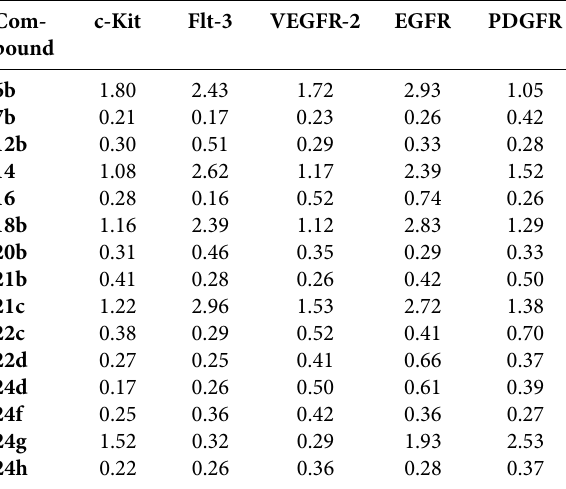
Table 3 . Inhibition of tyrosine kinases [enzyme IC 50 (nM)] by com- pounds 6b , 7b , 12b , 14 , 16 , 18b , 20b , 21b , 21c , 21d , 22c , 22d , 24d